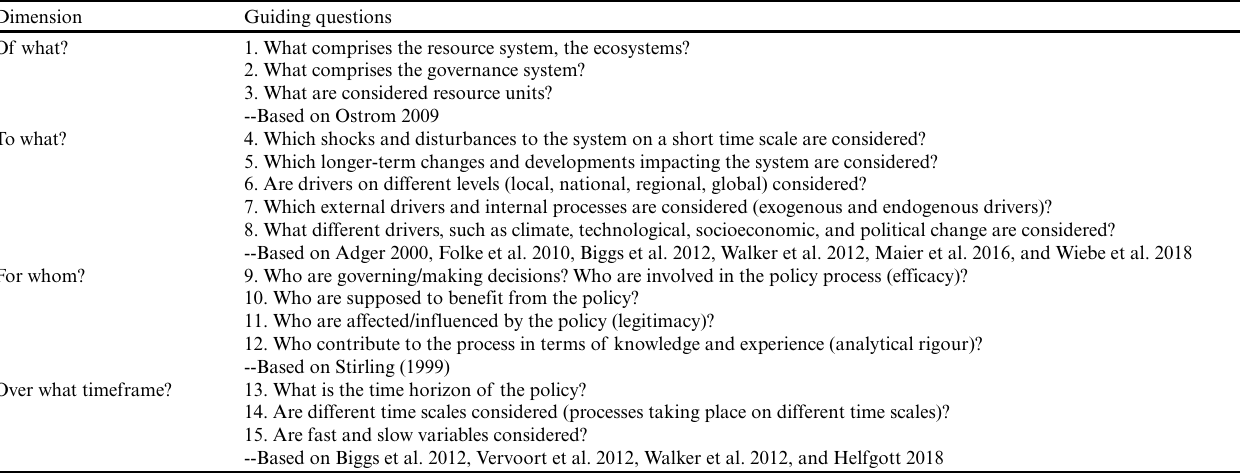
Table 1 . Analytical